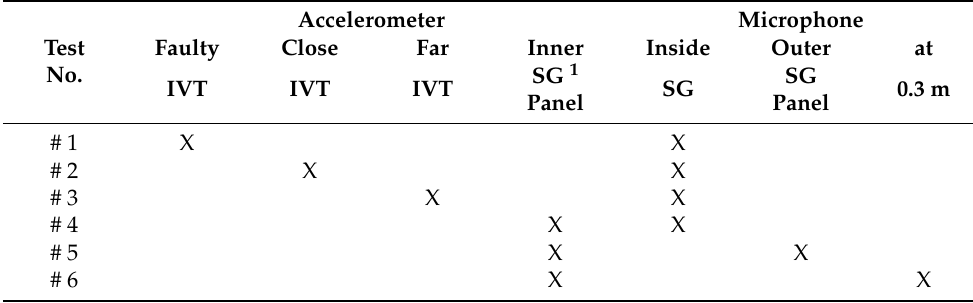
Table 5. Comparison tests carried